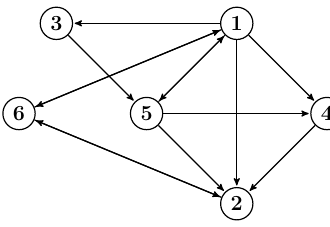
> 0 loops are not ii w ii